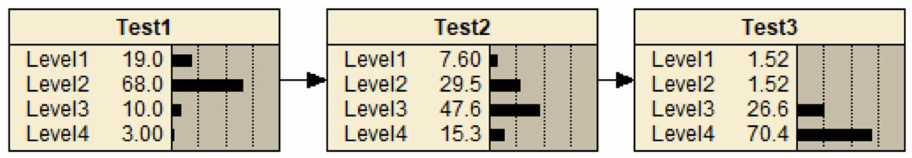
Figure 9. Level change of the second learner in